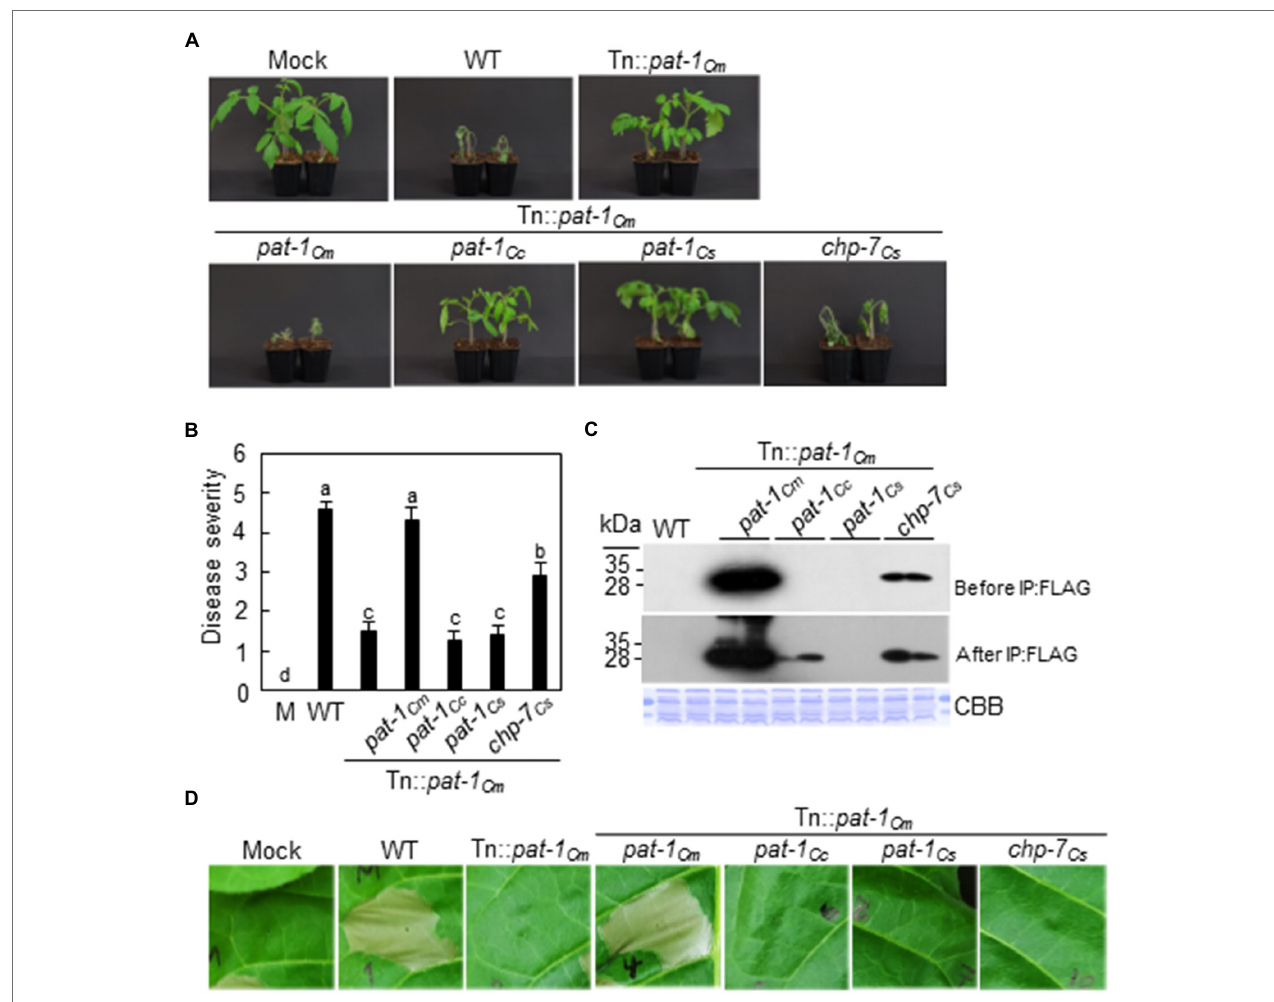
FIGURE 4 | Partial recovery of Clavibacter michiganensis LMG7333 Tn:: pat-1 Cm mutant virulence by chp-7Cs gene of C. sepedonicus . (A) Wilting symptom development by inoculation of Tn:: pat-1 Cm strain carrying the pat-1 Cm and its orthologs. Inoculated plants were observed for 2 weeks and photographed 14 dai. (B) Disease severity of wilting in tomato plants inoculated with the indicated strains at 14 dai. Error bars indicate SE ( n = 10). Nonparametric Kruskal–Wallis test with Dunnett’s multiple comparisons ( p < 0.05) was used to analyze the level of disease severity in tomato plants, and different letters indicate statistically significant differences at p < 0.05. (C) Expression and secretion of Pat-1 Cm and its orthologs in the complemented strains. All proteins were fused to FLAG on their C-termini and expressed in Tn:: pat-1 Cm . Total proteins from supernatant before and after immunoprecipitation (IP:FLAG) with anti-FLAG-agarose beads were analyzed by immunoblot using anti-FLAG antibody. CBB, Coomassie Brilliant Blue. (D) HR phenotype in Nicotiana tabacum after infiltration with the indicated strains. Leaves of 5-week-old plants were inoculated, and representative leaves were photographed 36 h after infiltration. Red dotted lines indicate infiltrated regions. Mock, 10 mM MgCl 2